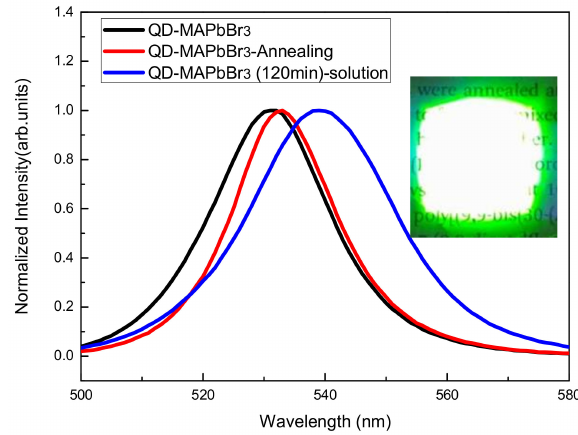
Figure 6. PL spectra of the QD-MAPbBr 3 films with and without annealing treatment. The inset shows a picture of the QD-MAPbBr 3 film excited by a 405-nm laser.